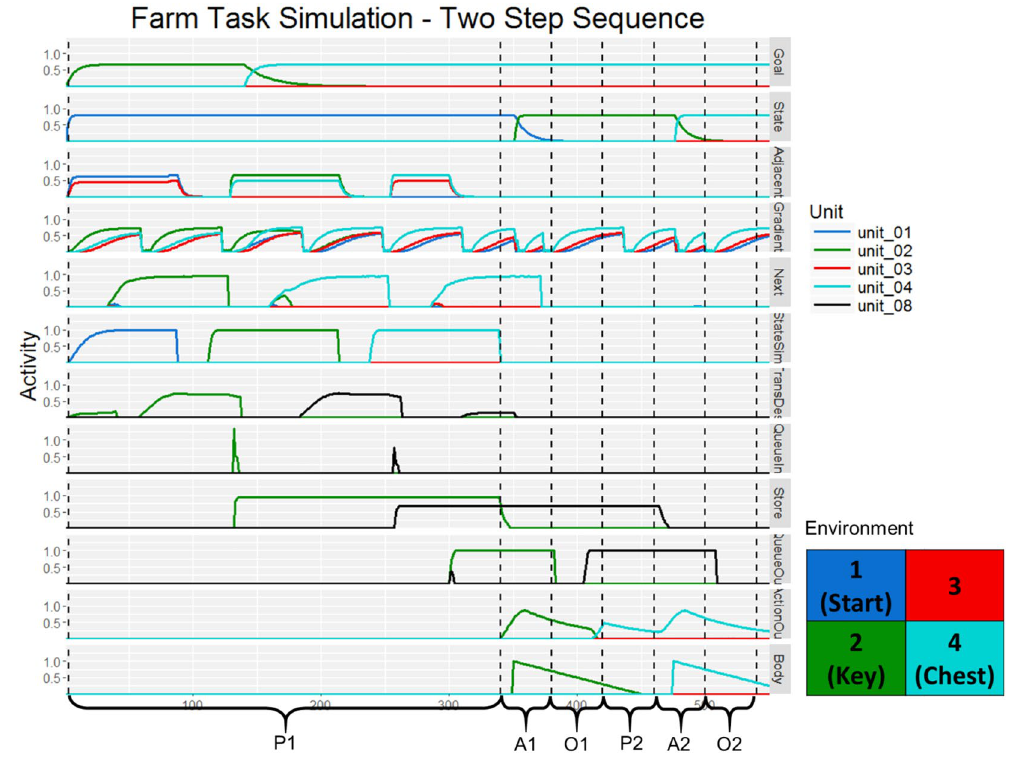
Figure 7. Model activity during a simulated two-step sequence of the Treasure Hunt task. The competitive queueing module first loads a plan and then executes it sequentially. State activity shows that the agent remains in state 1 for the first half of the simulation, while simulated-state shows the state transitions the agent simulates as it forms its plan. Adjacent-states receives input from simulated-state which, along with goal-gradient activity determines the desired next state and therefore the appropriate transitions to make. The plan is kept in queue- store which receives bursts of input from queue-input and finally executes the plan by sequentially sending output to queue-output which drives the motor system. To force the agent to go to the appropriate intermediate state, goal activity first reflects the key location and then the chest location. The vertical dashed lines indicate time periods used when creating the RDMs for the two-step sequence simulations. The first three time periods correspond to the first trial in the sequence while the latter three correspond to the second trial in the sequence. Again, the first planning period is much longer due to the nature of the model dynamics. During the second “planning” period (P2), the plan was already formed as must have been the case in the actual experiment